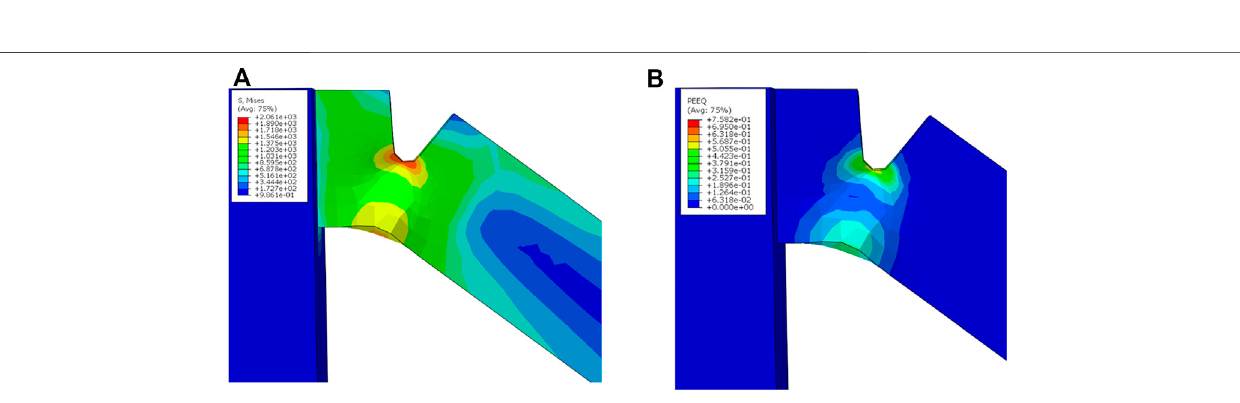
FIGURE 5 | FEA simulation on the microcantilever bending, showing (A) von Mises stress map and (B) equivalent plastic strain maps near the notch tip.